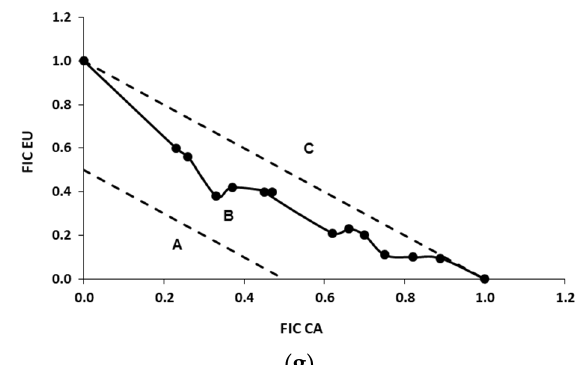
Figure 2. Isobolograms of selected combinations of EOs (CLEO, CBEO, and CLOEO) and pure compounds (VA, CA, and EU) against L. monocytogenes . ( a ) CLEO/CLOEO; ( b ) CBEO/CLEO; ( c ) CBEO/CLOEO; ( d ) CLOEO/VA; ( e ) CLEO/VA; ( f ) CBEO/VA; ( g ) EU/CA. See Figure 1 for the interpretation of the isobolograms.